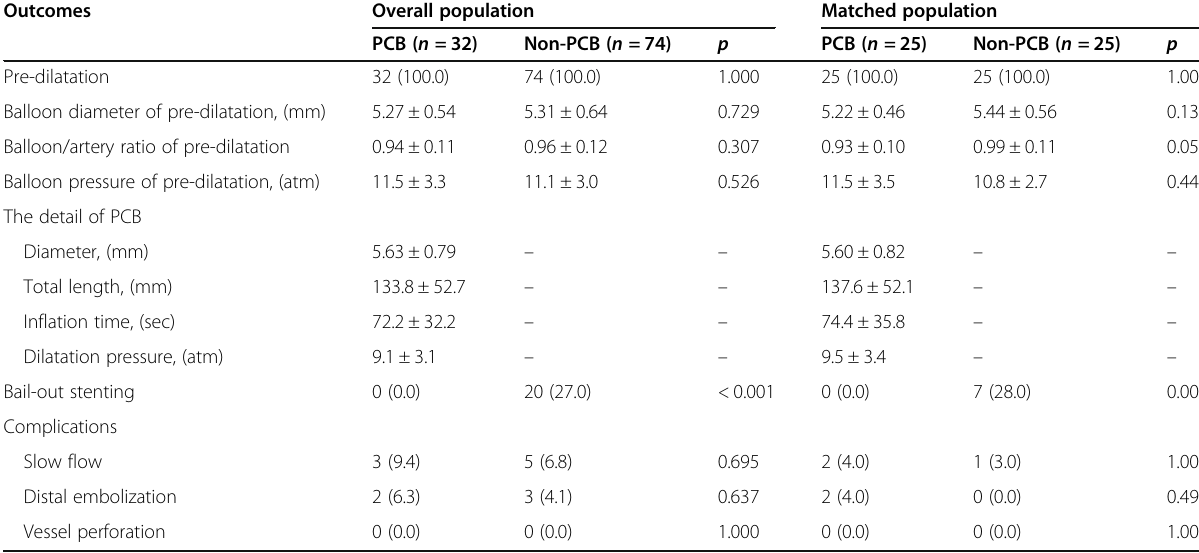
Table 3 Procedural Results